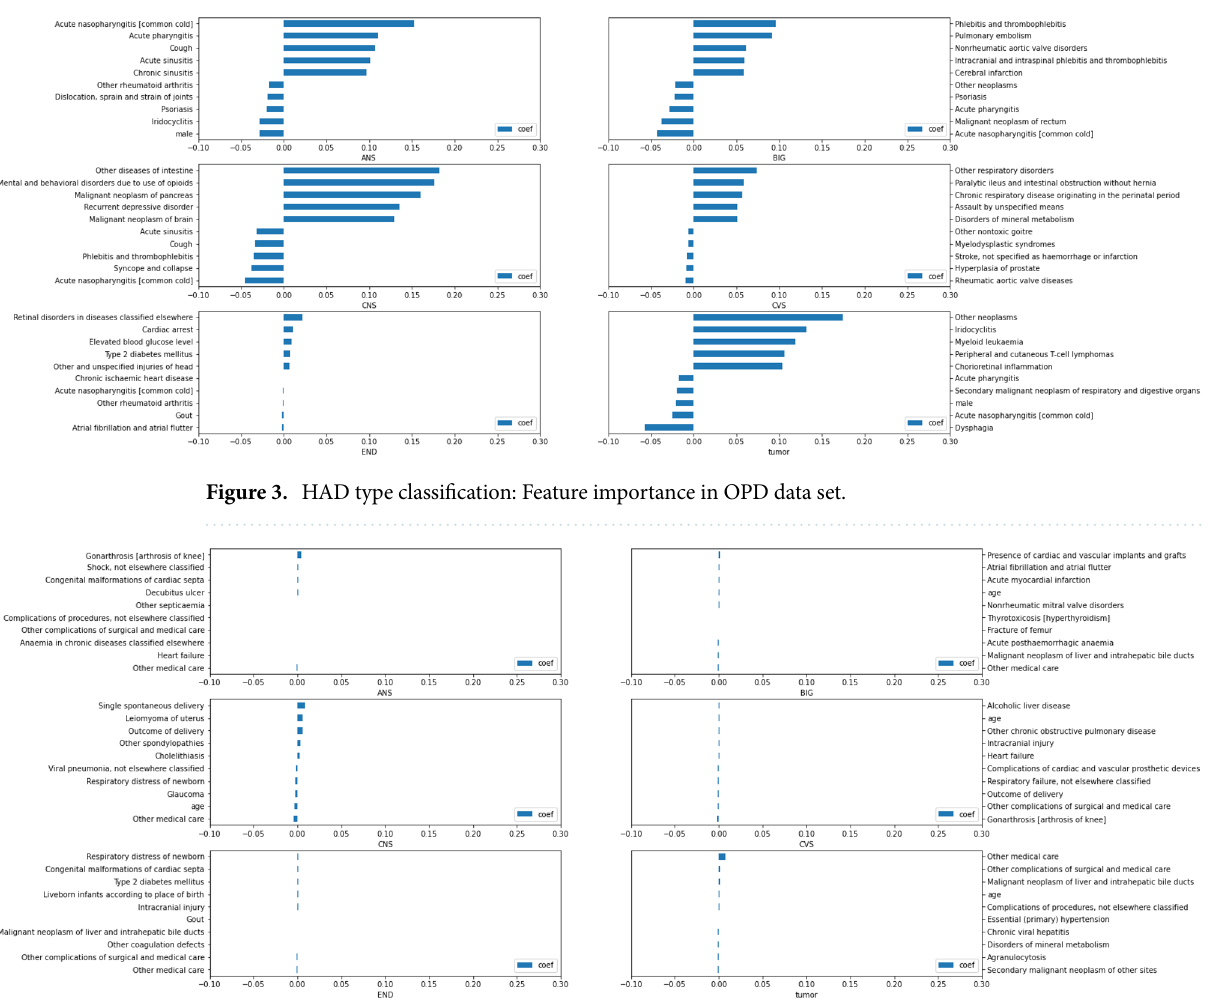
Figure 4. HAD type classification: Feature importance in IPD data